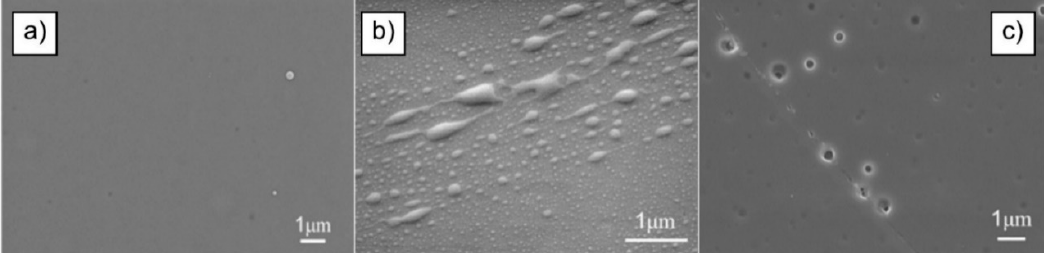
Figure 5. Planar view SEM images of hydrophobic coatings deposited by solution processing (coating B) ( a ) as-deposited; ( b ) after 600 h of UV exposure, and ( c ) after 1000 h of UV exposure, revealing blister formation, which later developed into pits on the surface.